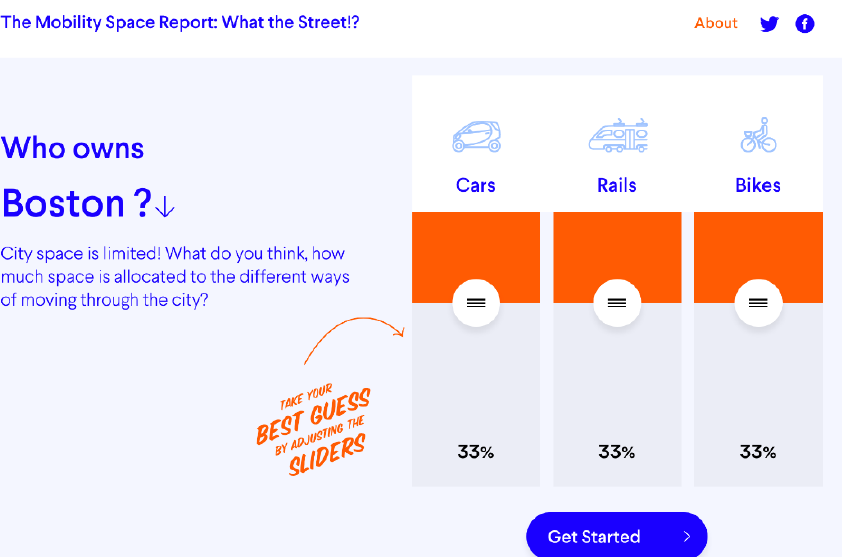
Figure 5. Using a linked set of sliders, empirical guesses on the distribution of mobility space are collected on the landing screen from site